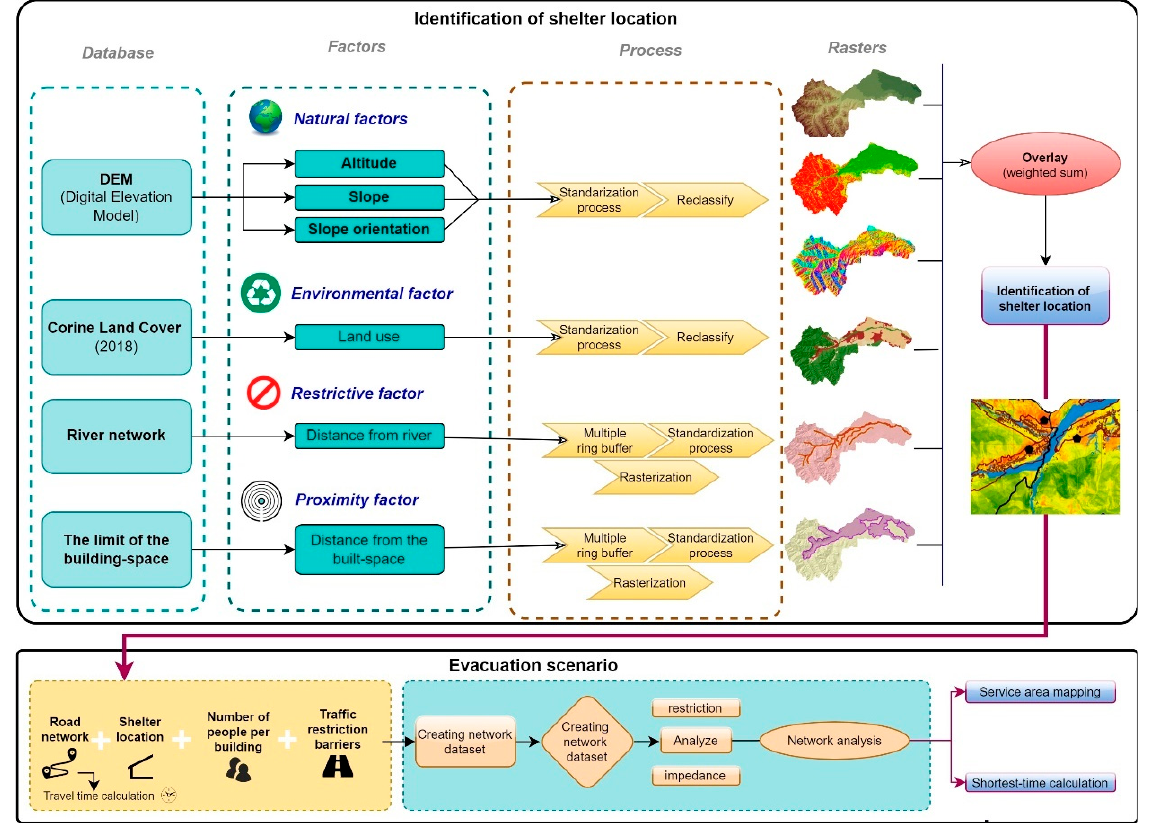
Figure 3. Flowchart. Table 1. Weight assessment for each factor included in the analysis.